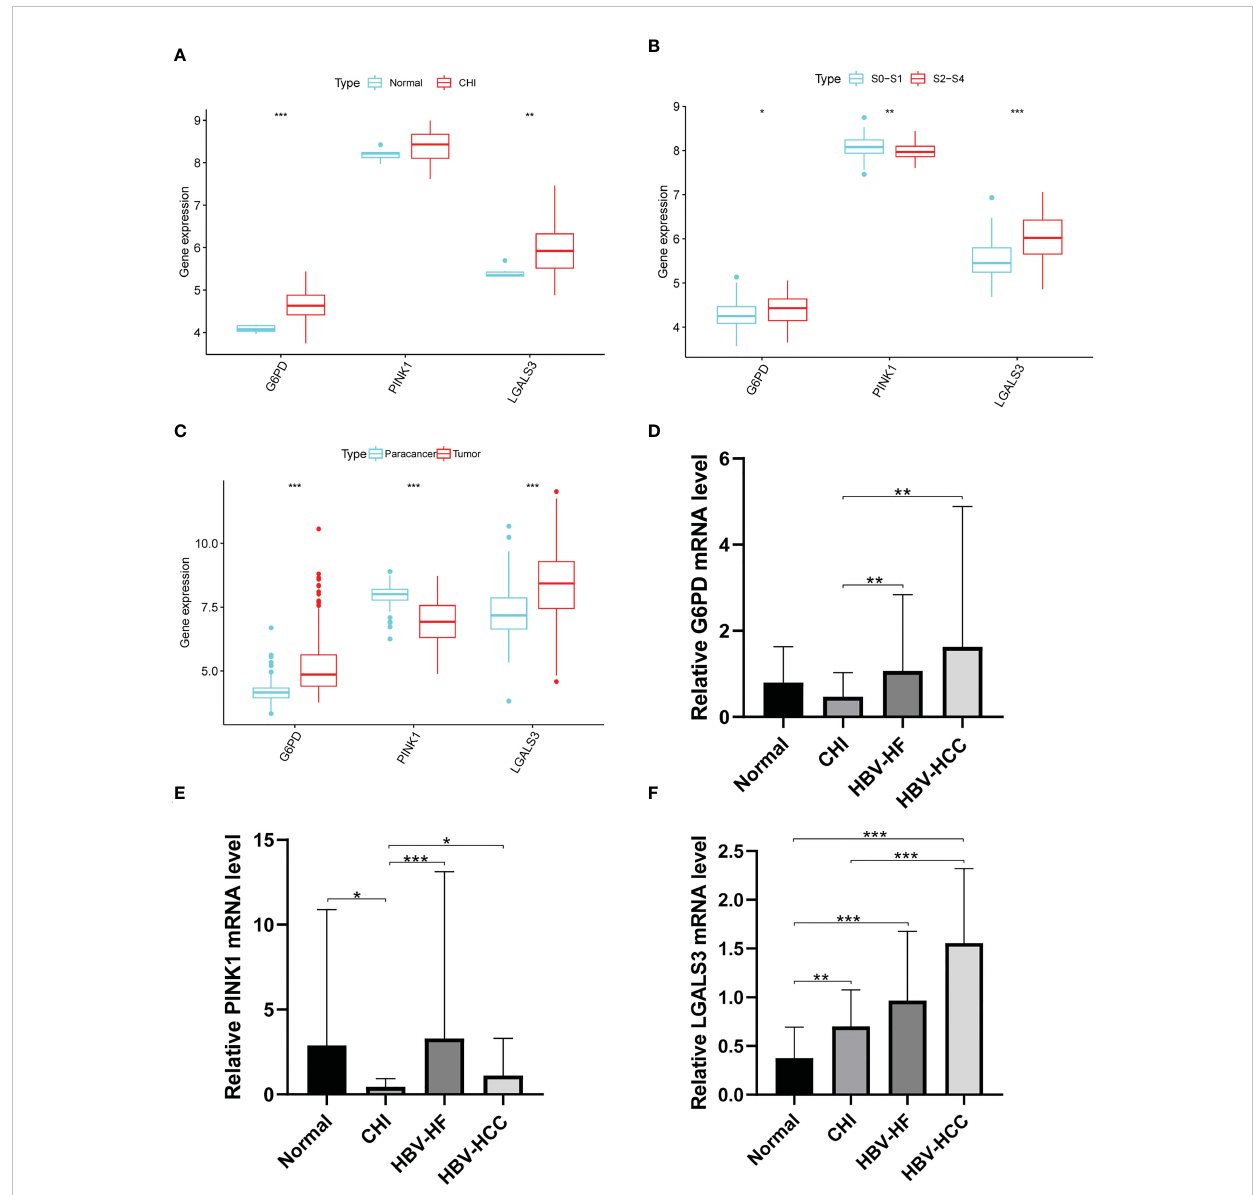
FIGURE 9 Expression of G6PD,PINK1 and LGALS3 in disease progression. Expression of G6PD, PINK1 and LGALS3 in (A) GSE83148, (B) GSE84044 and (C) GSE14520. (D – F) , The expression of G6PD, PINK1 and LGALS3 in PBMCs. * P < 0.05, ** P < 0.01, *** P < 0.001, ns, not signi fi